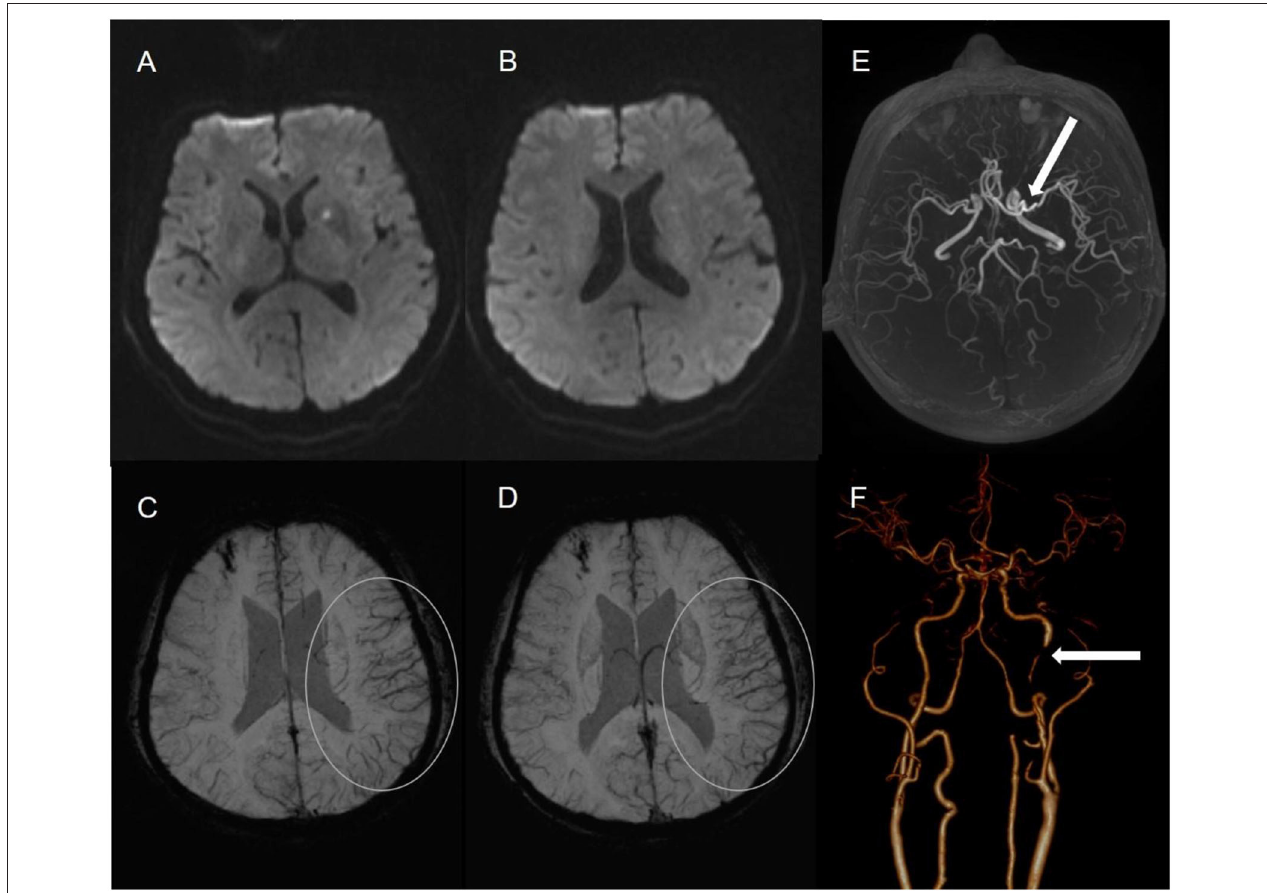
FIGURE 3 | A 61-male patient with left LI (A,B) . SWI indicates APCV in the left hemisphere [ (C,D) white circle]. CTA showed left internal carotid artery occlusion [ (F) white arrow]. The status of cerebral arterial circle was graded as good with the presence of contrast filling from the M1 to M3 of MCA and anterior cerebral artery [ (E) white